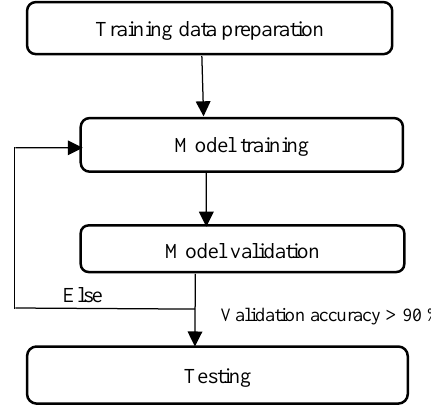
Figure 2. Overall methodology used in the